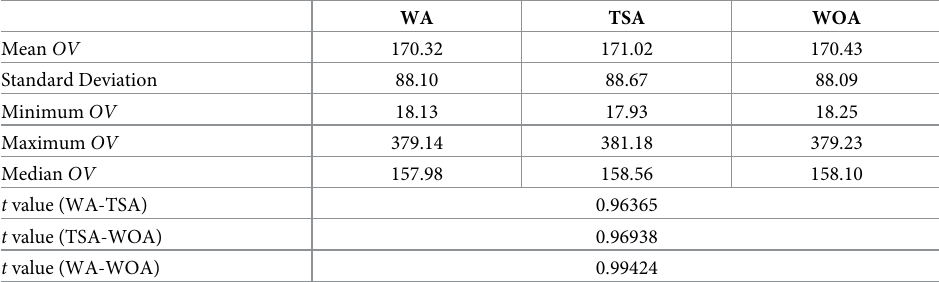
Table 6. Statistical information about the objective values of the algorithms.